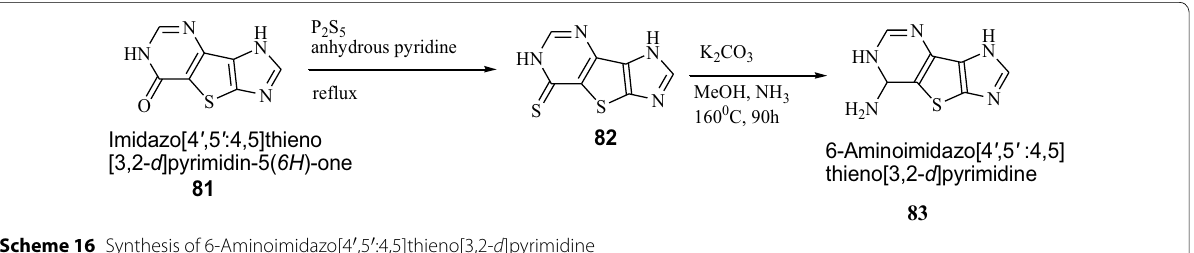
Table 16 Antitumor activity of synthesized compounds Compound